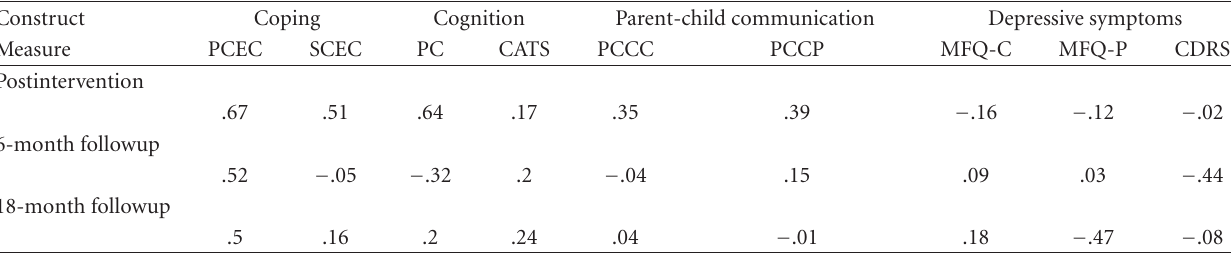
Table 4: E ff ect sizes (Cohen’s D) for outcomes across